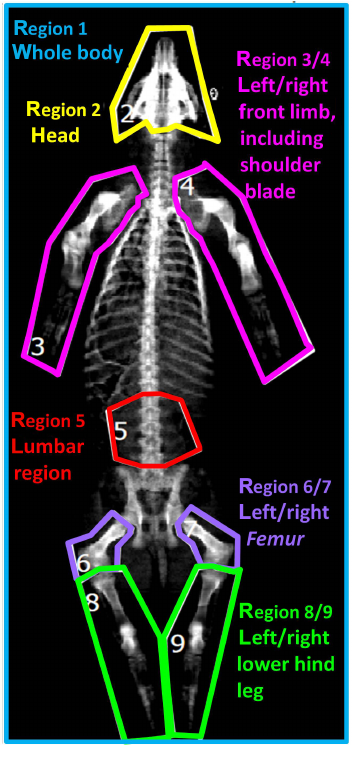
Figure 1. Defined body regions in the two-dimensional DXA im-